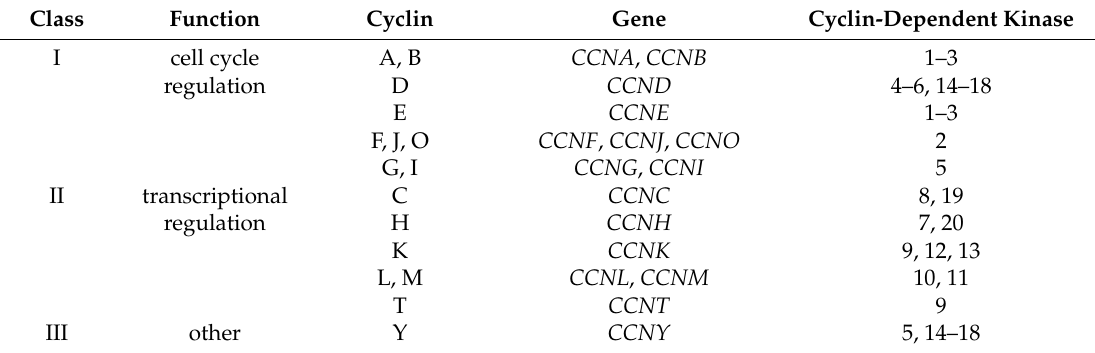
Table 1. The human cyclin family. Cyclins preferentially bind a specific Cdk, e.g., cyclin C is the regulatory subunit for Cdk8 although some promiscuity has been observed. Cyclin-Cdk kinases comprise cell cycle regulators (Class I), transcription factors (Class II), and others with unspecific functions (Class III)